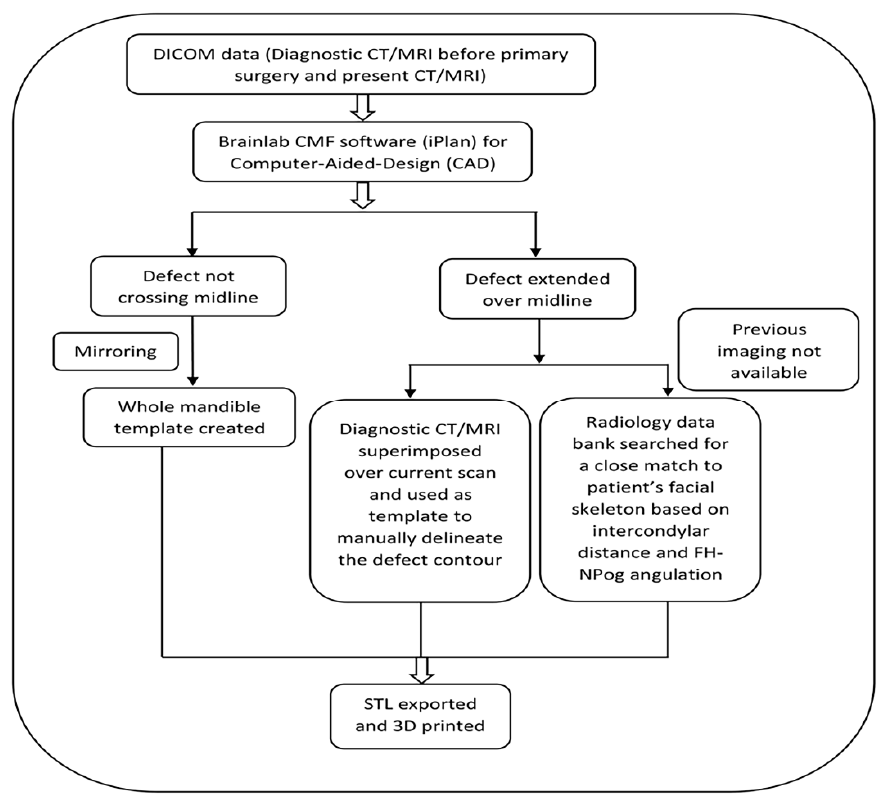
Figure 1. Virtual planning flowchart for creation of defect template .